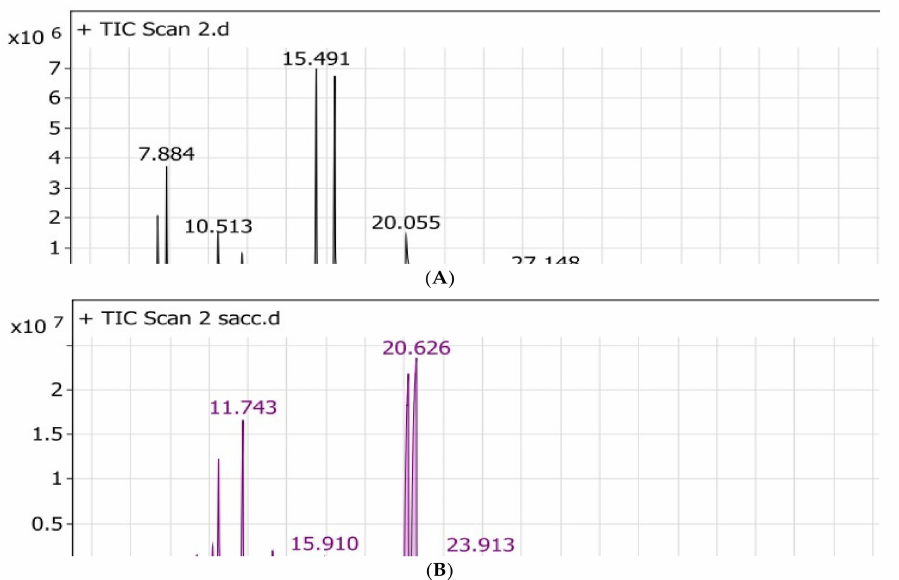
Figure1. Volatilechromatogramsfor( A ) S.satureioides HDoiland( B )nanoemulsionsof S.satureioides oil.